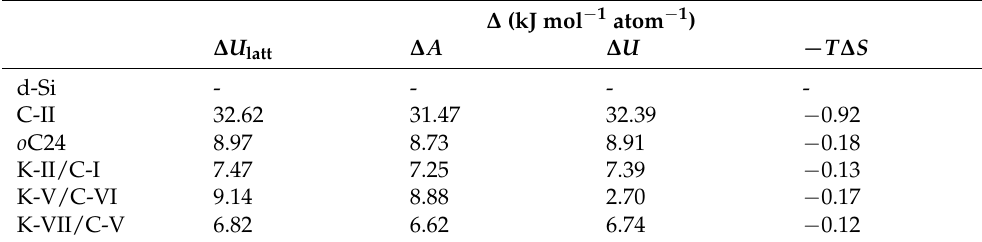
Table 4. Relative energies of the five framework structures examined in this study compared to bulk diamond Si. For each system we show the differences in the lattice internal energies U latt together with the differences in the Helmholtz energies A = U − TS at T = 300 K and the corresponding differences in the internal energy U = U latt + U vib and entropy − TS